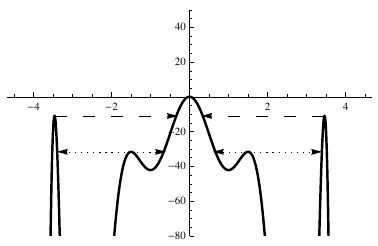
Figure 3. The function G ( x ) in Example 2. There are two symmetric non-trivial period annuli and two symmetric pairs of trivial period annuli in the respective equation x (cid:48)(cid:48) + g ( x ) = 0.